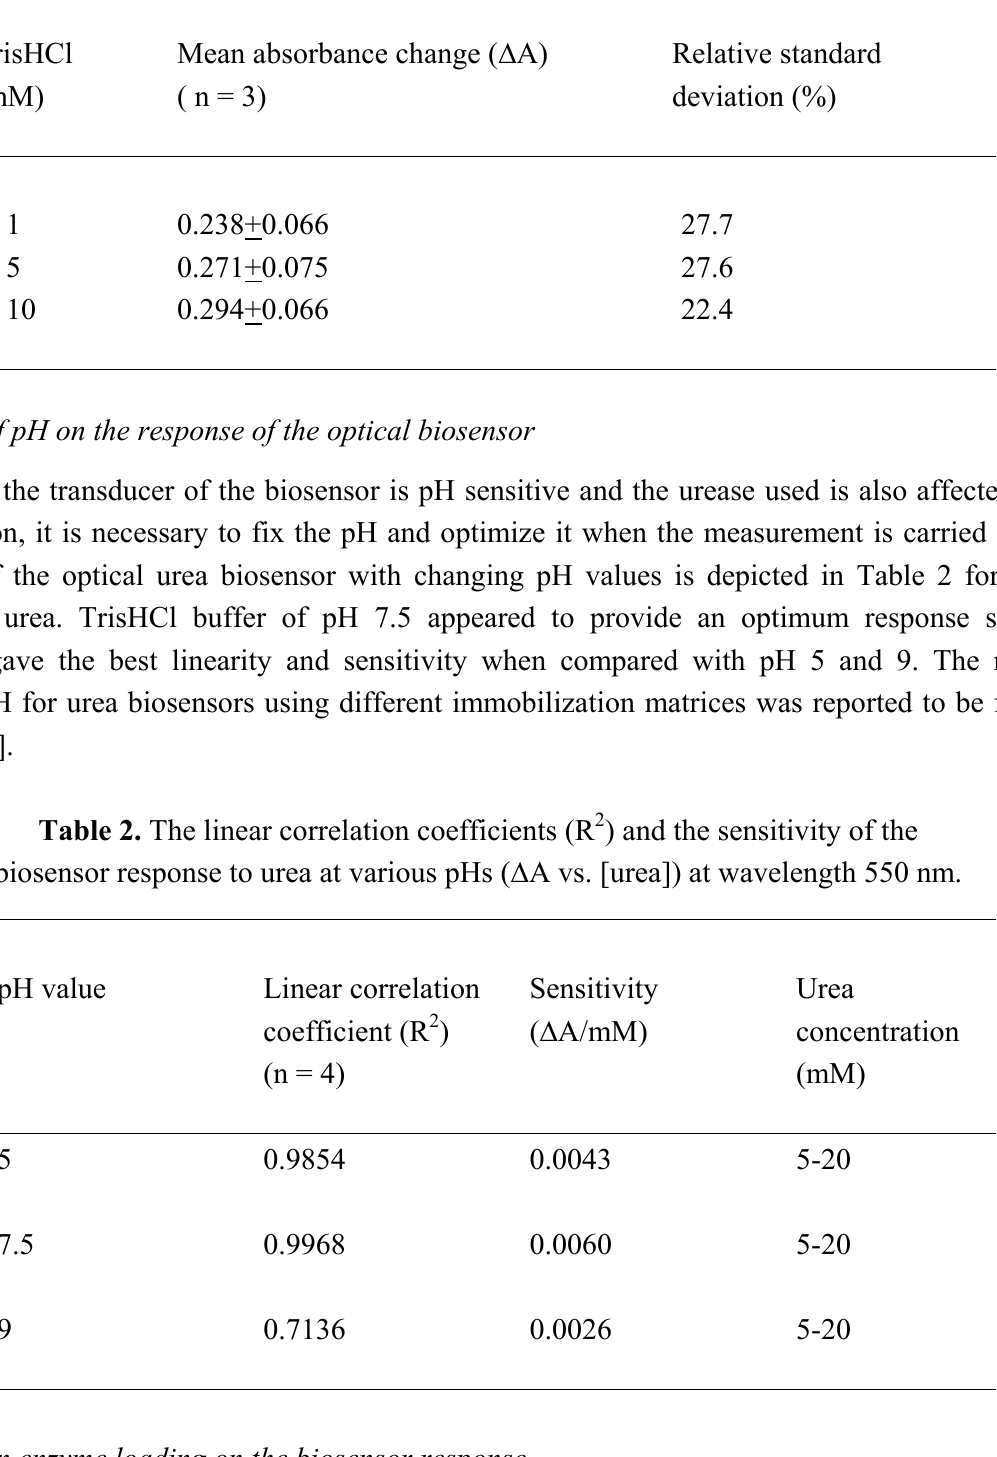
Table 1. The changes in absorbance ( Δ A) of the urea biosensor to